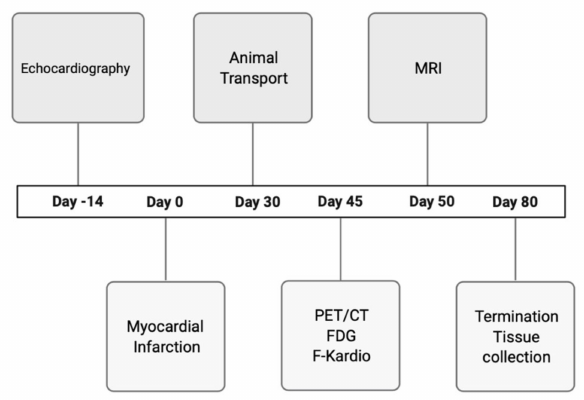
Figure 5. Experimental design and timeline of the procedure. SYN1 and [ 18 F]-FDG radiotracers were used in PET/CT scan in order to evaluate the perfusion and metabolism in the myocardium. Assessment of cardiac hemodynamic param- eters was performed using MRI in order to determine how the cardiac infarction influenced the left ventricular region and its subsequent contractility. A 7T Bruker Biospec scanner (70/30 USR, Bruker, Biospin, Ettlingen, Germany) was used with a set of coils—only the surface coil and transmitted cylindrical radiofrequency volume coil (10 mm and 8.6 cm in- ner diameter, respectively) were applied. Anaesthetized mice (1.5% isoflurane in a mixture of oxygen and air) were placed in an MR-compatible bed. Based on pilot scans, geometry for the four-chamber view of the long axis of the heart has been set. Using four-chamber view, a set of short-axis scans was performed with IntraGateFLASH protocol covering all ventricles’ volumes. Protocol parameters used in the experiment: echo time = 3 ms, repetition time = 10 ms, number of repetitions = 120, field of view = 25 mm × 25 mm, slice thickness = 0.9 mm, spatial resolution = 0.13 × 0.13 mm per pixel. Each heartbeat cycle contained 15 images. In order to improve image quality, a gating system was used. Reconstructed MRI data in DICOM format were further analysed to perform a calcu- lation of end-systolic and end-diastolic volume of heart ventricles. For each short-axis scan, inner edges of the ventricle were outlined manually in OsiriX DICOM Viewer (Pixmeo SARL, Bernex, Switzerland). End-systolic and end-diastolic images were defined and used further for the calculation of ventricles